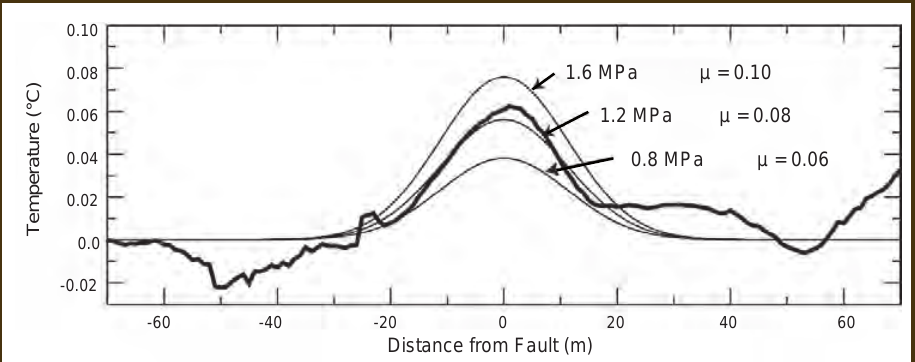
Figure 3. Temperature anomaly recorded in the Taiwan borehole and interpretation in terms of maximum friction coefficient (Kano et al.,